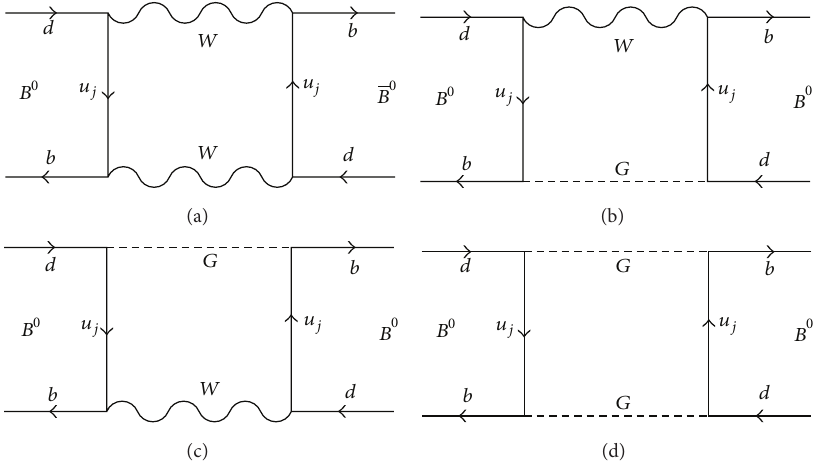
0 Figure 7: The 𝐵 0 − 𝐵 (representative) box diagrams with different combinations of the gauge bosons (𝑊, 𝐺) and the fermions (𝑢 𝑖 , 𝑢 𝑗 ) in the internal lines. The same diagrams contribute to 𝐵 𝑠 − 𝐵 𝑒𝑚 𝑏 𝑂 = 𝑠 𝜎 𝜇 ] 𝑏 𝐹 7 𝐿 𝑅 𝜇 ] (photonic dipole 16𝜋 2